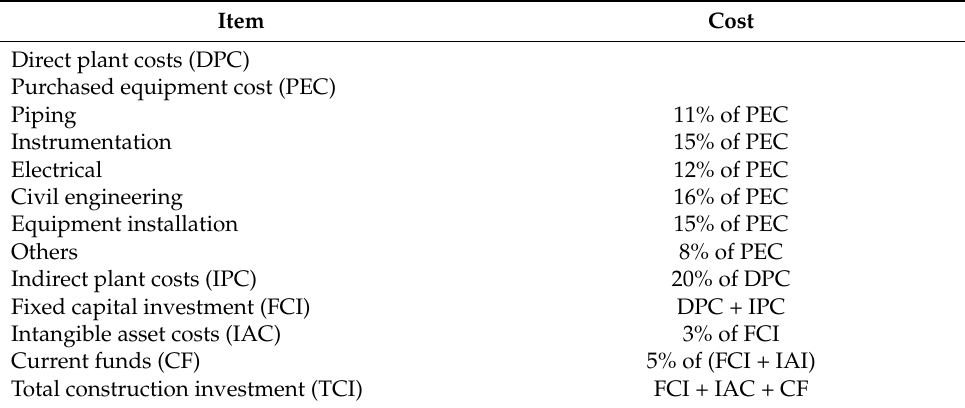
Table 1. The composition of estimated total construction